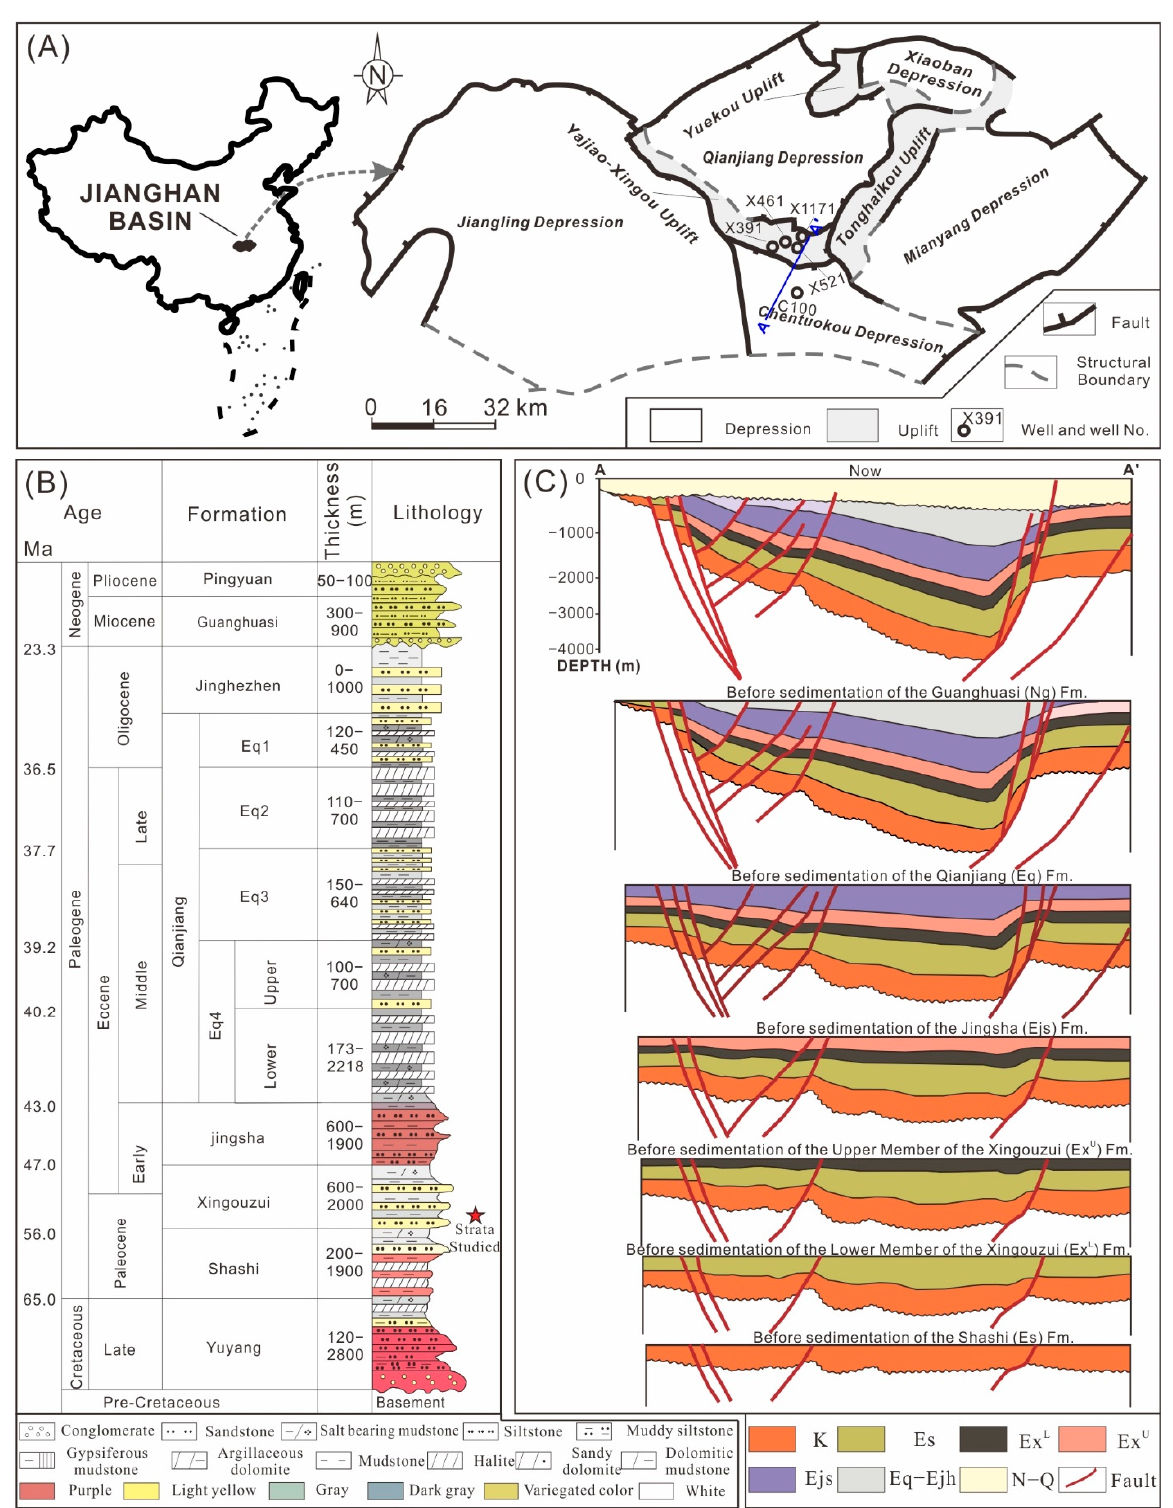
Figure 1. ( A ) Location and an overview map of the Jianghan Basin. ( B ) Simplified stratigraphic column [21]. ( C ) The tectonic evolution of the study area, after the Exploration and Development Research Institute Sinopec Jianghan Oilfield Company, 2020. Fm = Formation.